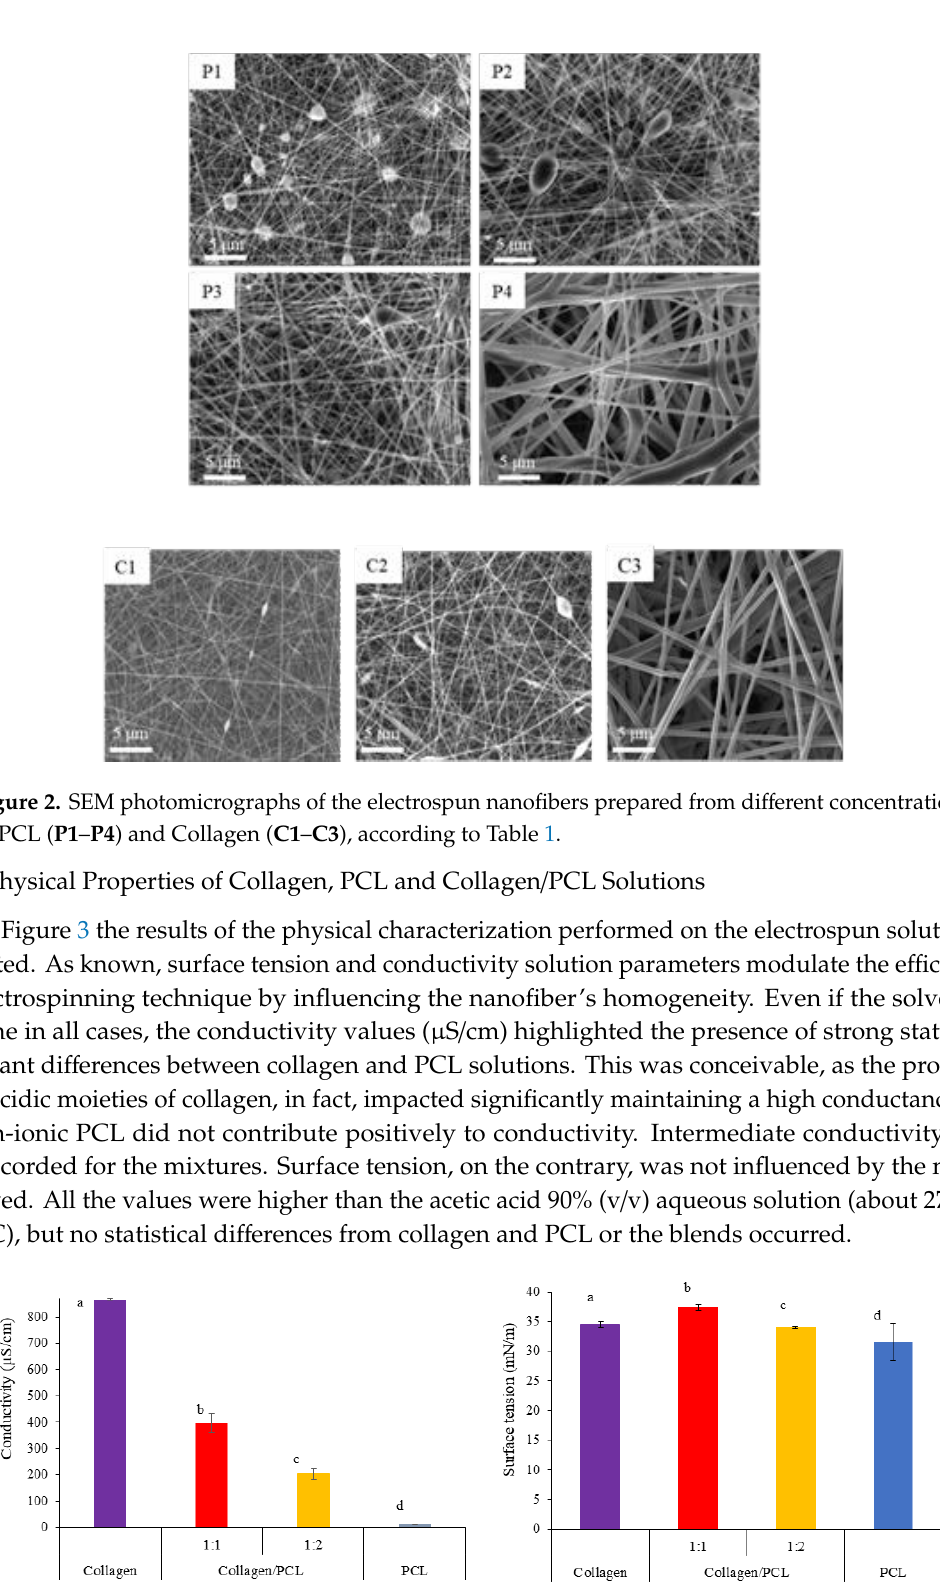
Figure 3. Conductivity ( µ S / cm) (on the left) and surface tension (mN / m) (on the right) values of collagen, collagen / PCL 1:1 and 1:2 (w / w) and PCL solutions prepared at total 20% (w / w) concentration. ANOVA 1 way—MRT ( p < 0.05) (mean values ± s.d.; n = 5) for conductivity: a vs. b, a vs. c, a vs. d, b vs. c, b vs. d, c vs. d. ANOVA 1 way—MRT ( p < 0.05) (mean values ± s.d.; n = 5) for surface tension: Not